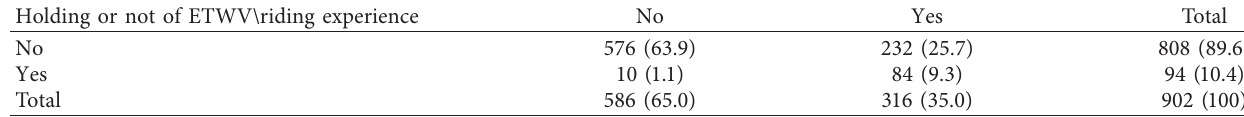
Table 5: ETWV’s holding time and riding experience.